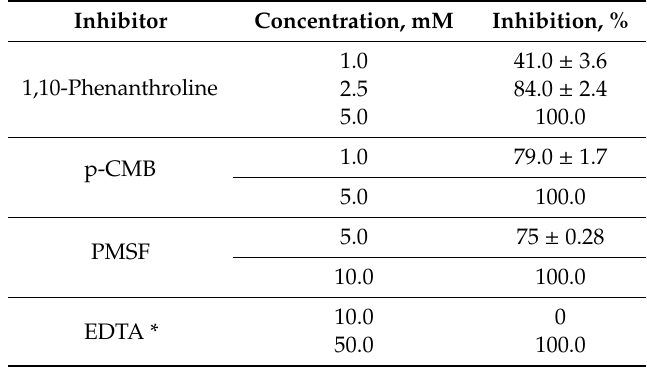
Table 4. Effect of inhibitors on BlpLc activity with respect to autoclaved cells of S. aureus 209P. Inhibitor